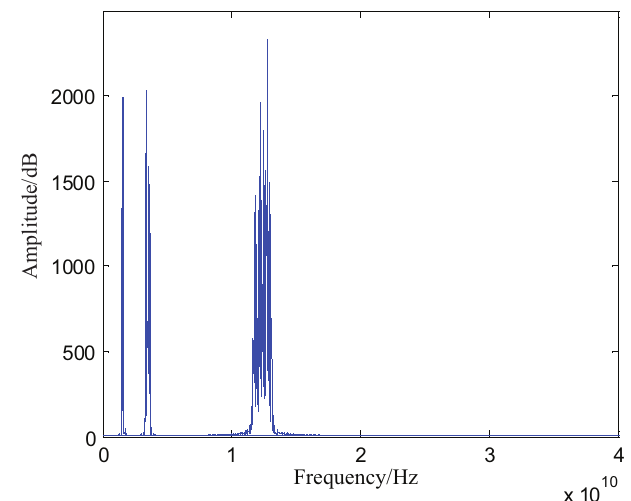
Figure 2. Spectrogram of three time-domain overlapped satellite